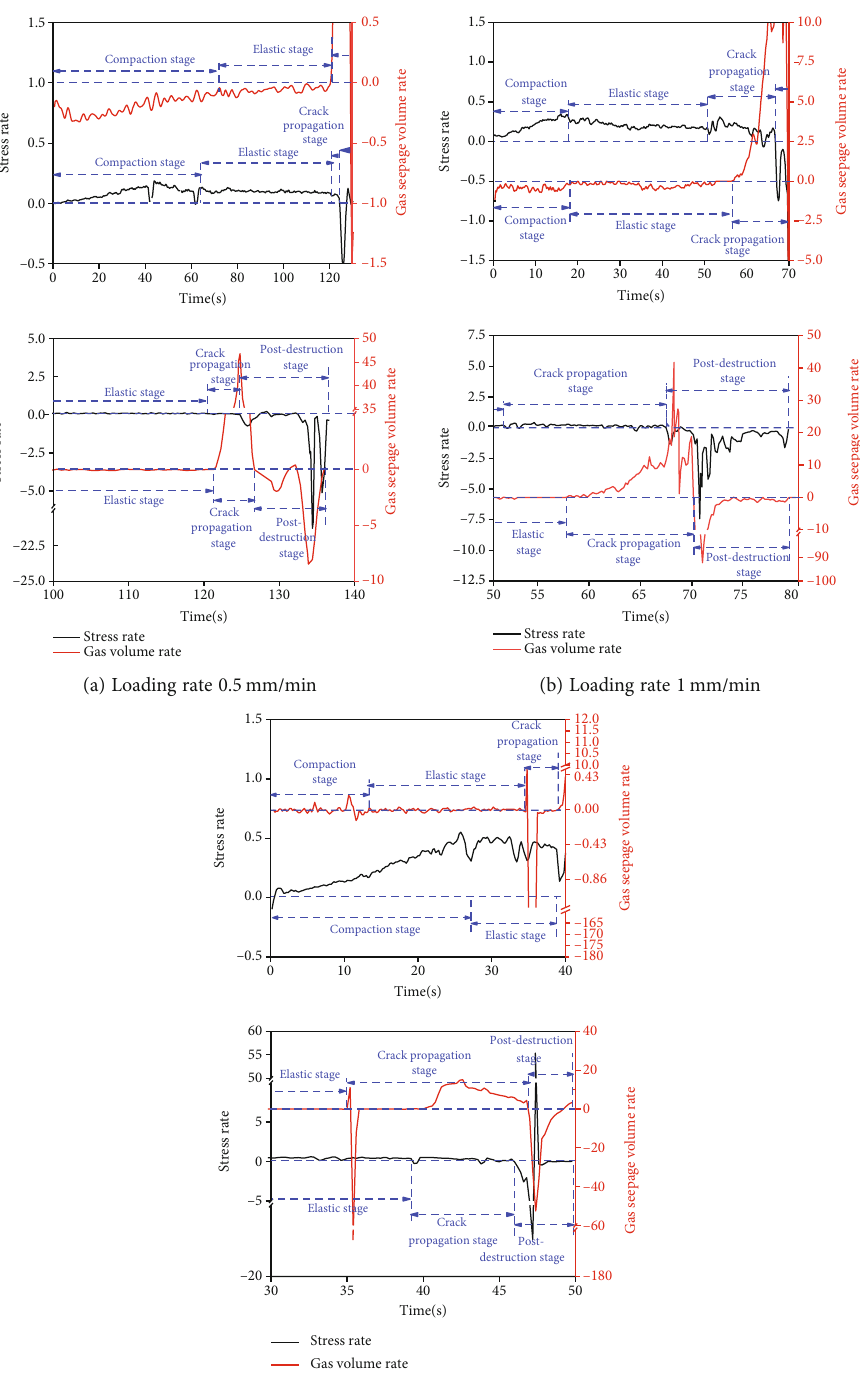
Figure 6: Rate curves of stress and gas seepage volume under di ff erent loading